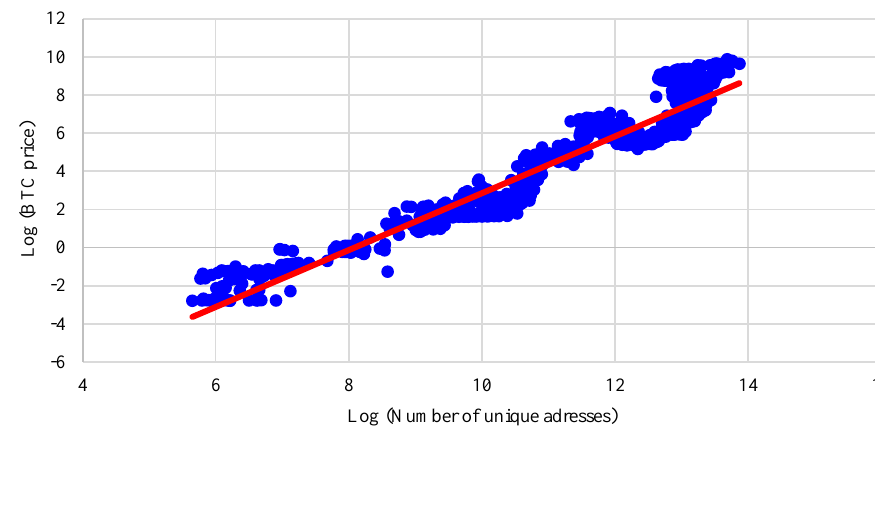
Figure 5 : Generalised Metcalfe’s law for Bitcoin’s